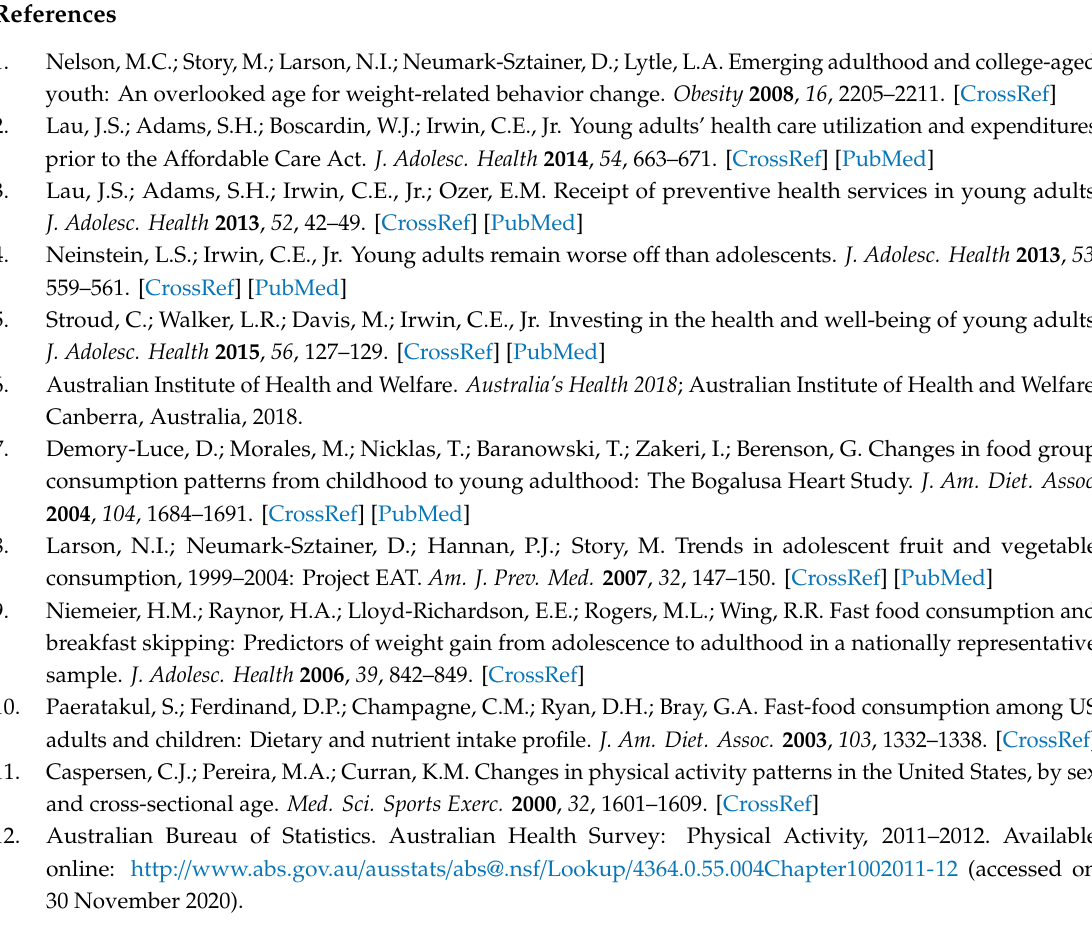
Figure A2. Leximancer TM generated concept map for Forum 14: The Healthy Eating Guide.